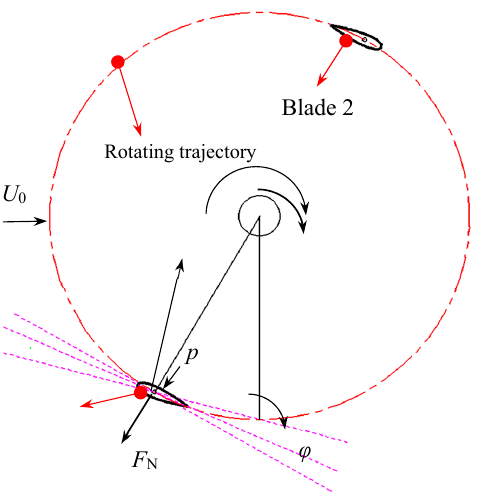
Figure 2. Definitions of velocity and force.